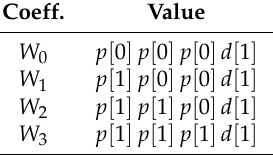
Table 1. Non-zero and distinct positive filter coefficients for serial input. Coeff.